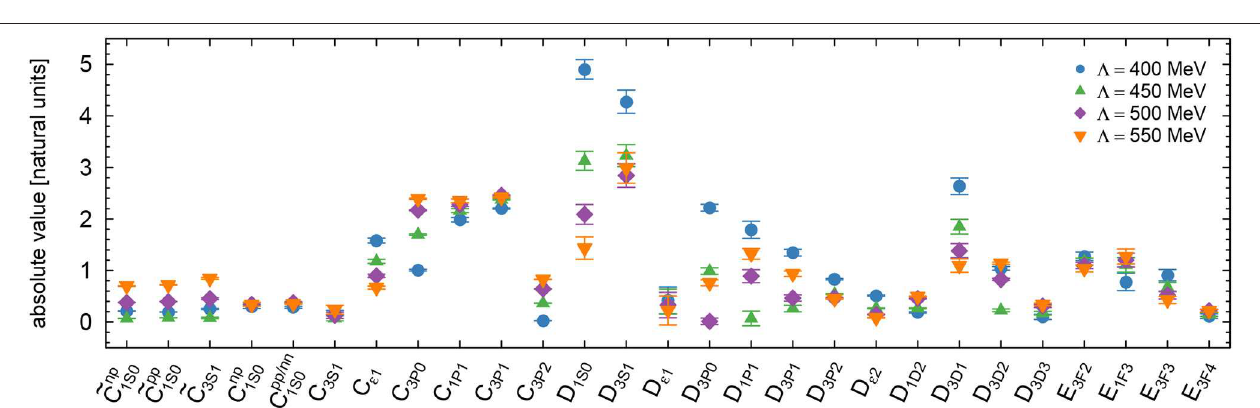
FIGURE 7 | Absolute values of the contact interaction LECs in natural units at the order N 4 LO + for all considered cutoffs. Error bars represent the statistical errors of the LECs.